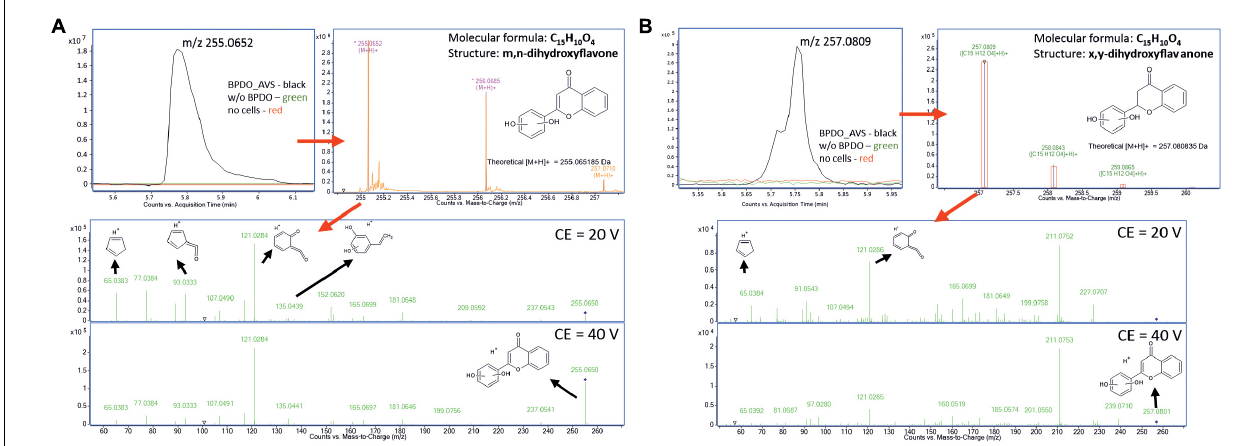
FIGURE 7 | Analysis of products of flavone (A) and flavanone (B) transformation mediated by BPDO_AVS. Section of LC-MS chromatograms are shown of resting cell assay supernatants, together with the mass spectra of the corresponding compounds (B) , the fragmentation spectra of the major molecular features (m/z = 255.0652 and 257.0809, respectively) acquired using two different collision energies with suggested interpretation of MS/MS spectra and proposed structures of the corresponding compounds, determined as m,n-dihydroxyflavone and x,y-dihydroxyflavanone,